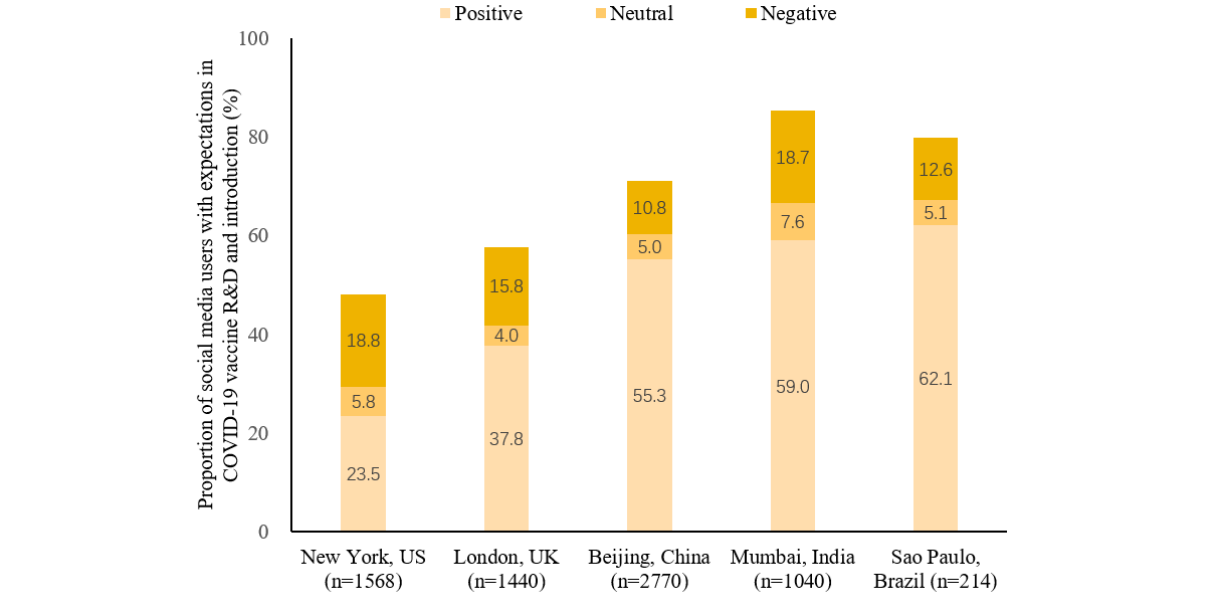
Table 1 conveys confidence, complacency, and convenience related to COVID-19 vaccination on social media. Although most tweets in each metropolis regarded COVID-19 vaccination as important and effective, proportions of tweets perceiving COVID-19 vaccines as unsafe in high-income countries (HICs; 133/1568, 8.5% in New York and 157/1440, 10.9% in London) were much higher than those in other metropolises (<4%). These